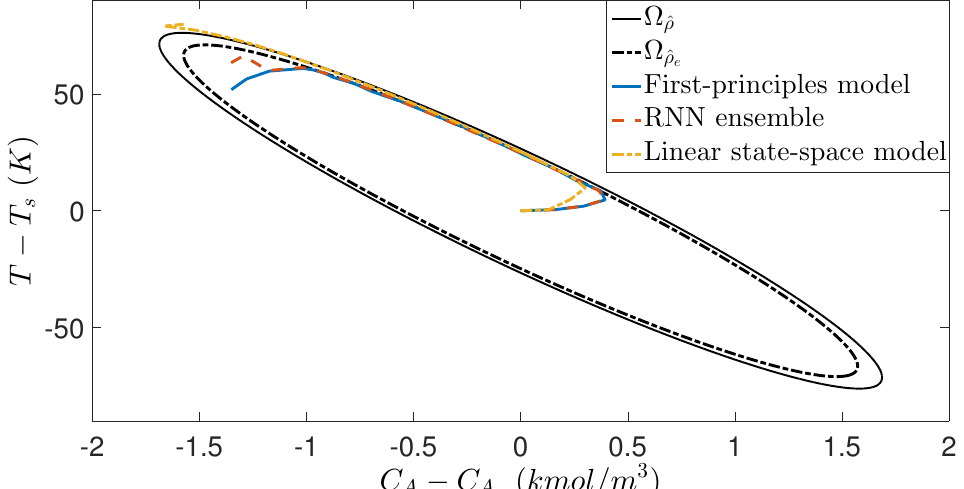
Figure 6. The state-space profiles for the closed-loop CSTR under the LEMPC using the following models: the first-principles model (blue trajectory), the RNN model ensemble (red trajectory) and the linear state-space model (yellow trajectory) for an initial condition (0, 0).